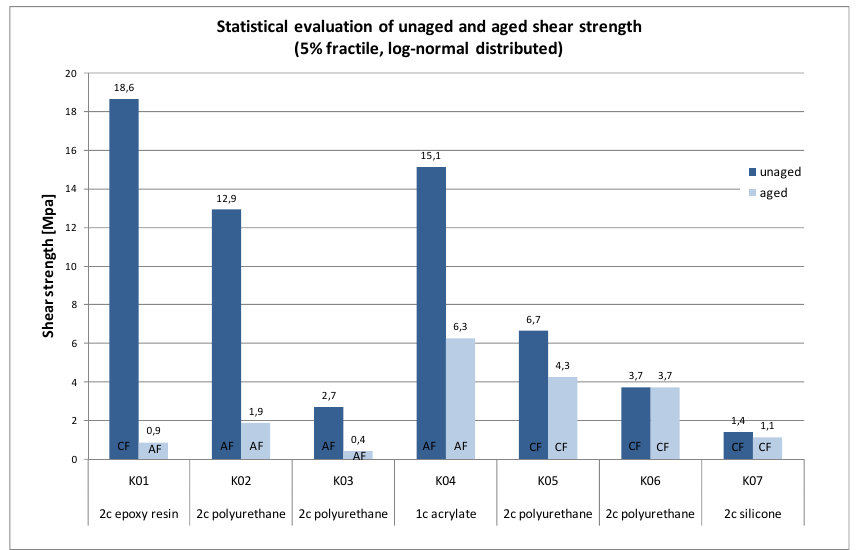
Figure 3: Decrease of shear strength after water bath